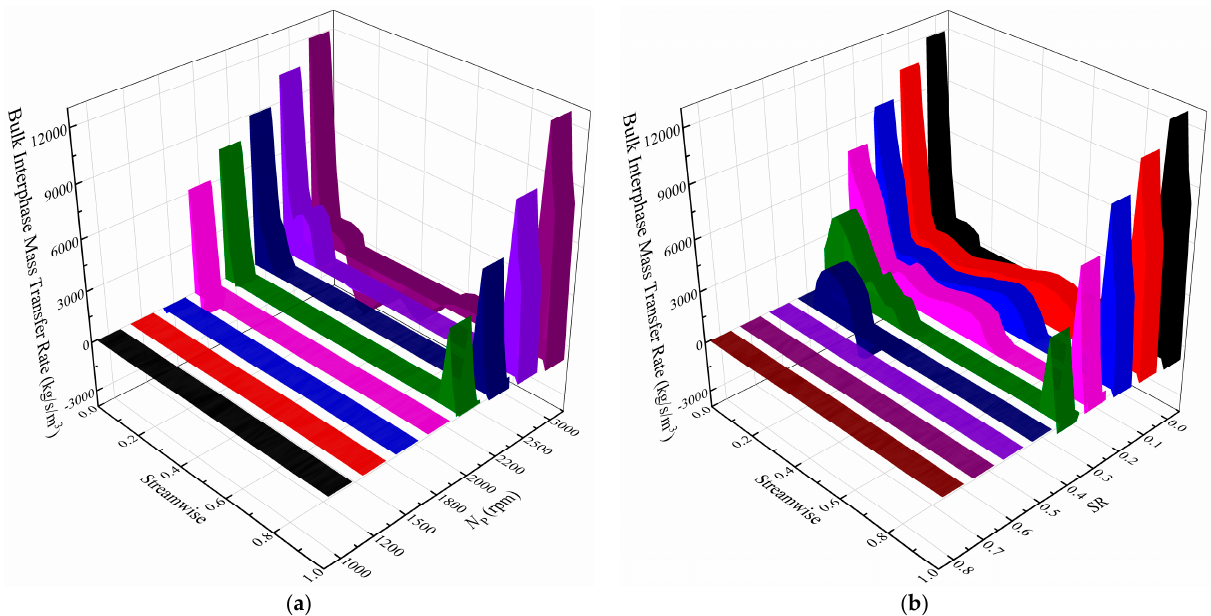
Figure 20. The bulk interphase mass transfer rate between oil and vapor on stator blade under various conditions. ( a ) Under various N P when SR = 0. ( b ) Under various SR when N P = 3000 rpm.